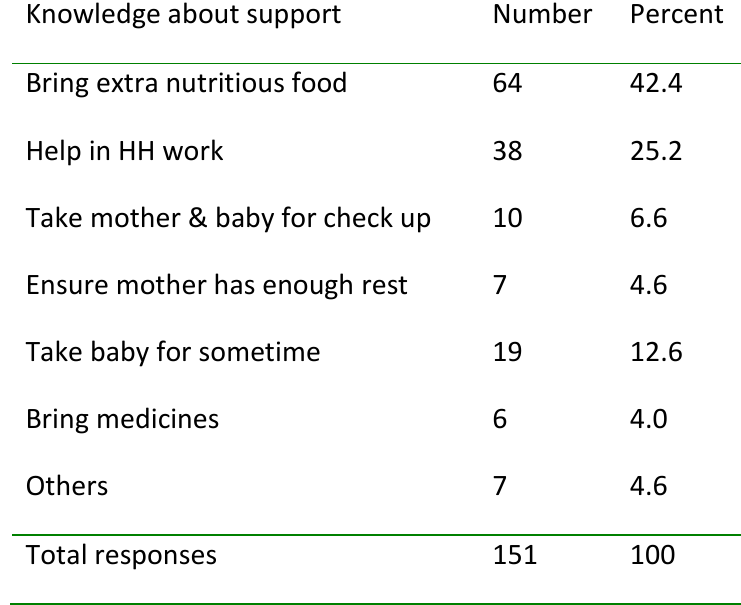
Table 2: Knowledge about support during